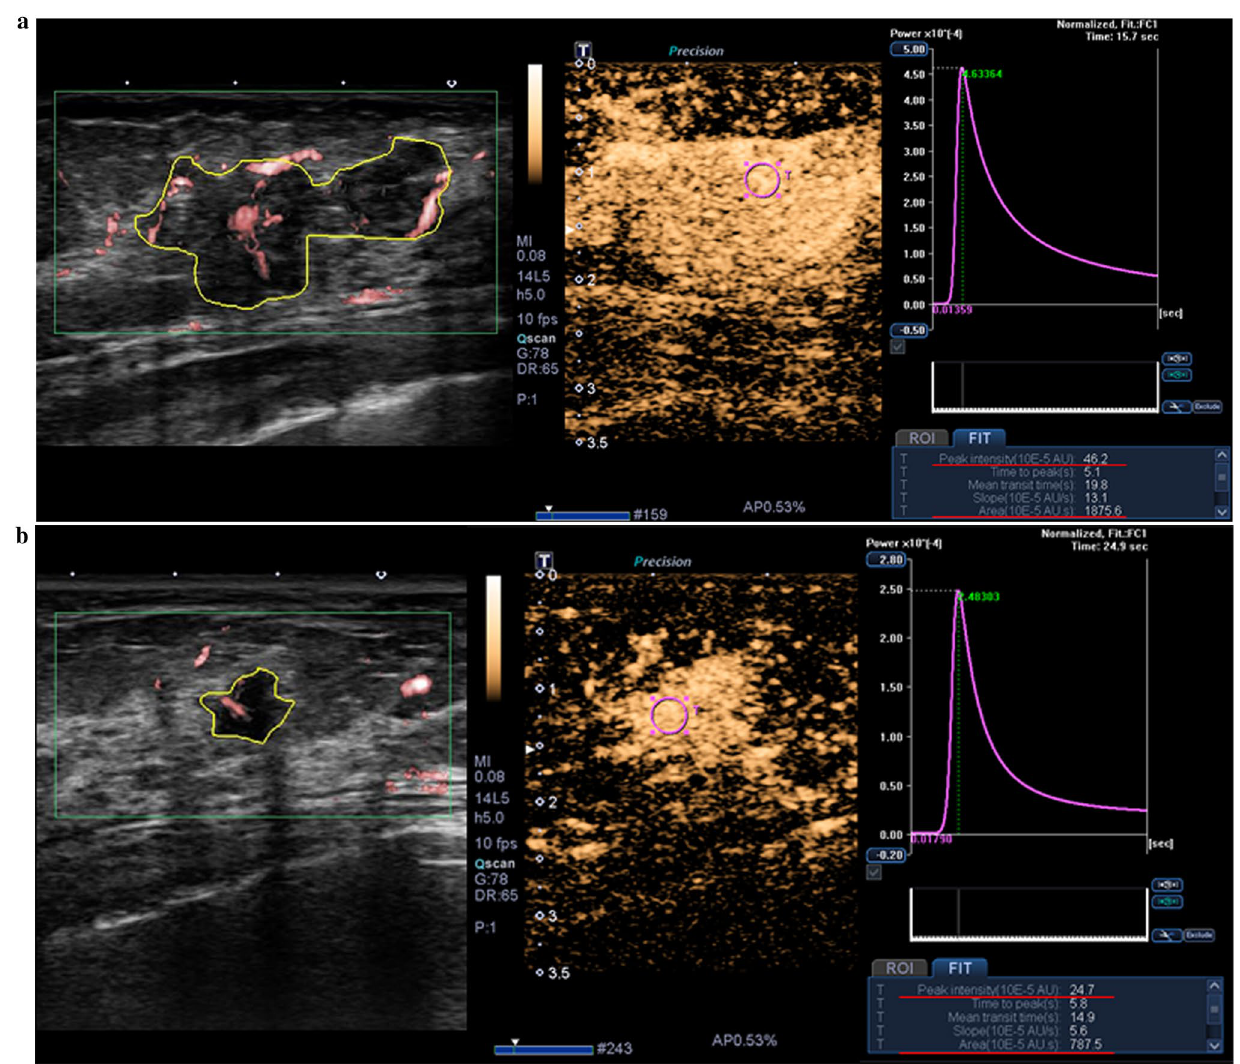
Fig. 4 Comparison of vascular US parameters according to the tumor size (≤ 20 mm vs. > 20 mm). a Microvascular US and contrast-enhanced US images of a 35 mm-sized invasive ductal carcinoma in a 47-year-old female show increased peak intensity, 46.2 × 10 −5 AU (above the mean value of 34.2 × 10 −5 AU), and area under the curve, 1875.6 × 10 −5 AU·s (above the mean value of 890.0 × 10 −5 AU·s). DNA sequencing results for the cancer showed the presence of rs35597368 in PDGFRA . b Microvascular US and contrast-enhanced US images of a 14 mm- sized invasive ductal carcinoma in a 62-year-old female show low peak intensity, 24.7 × 10 −5 AU (below the mean value of 34.2 × 10 −5 AU), and area under the curve, 787.5 × 10 −5 AU·s (below the mean value of 890.0 × 10 −5 AU·s). DNA sequencing results for the cancer showed the absence of rs35597368 in PDGFRA and rs2305948 in KDR . SNP, single nucleotide